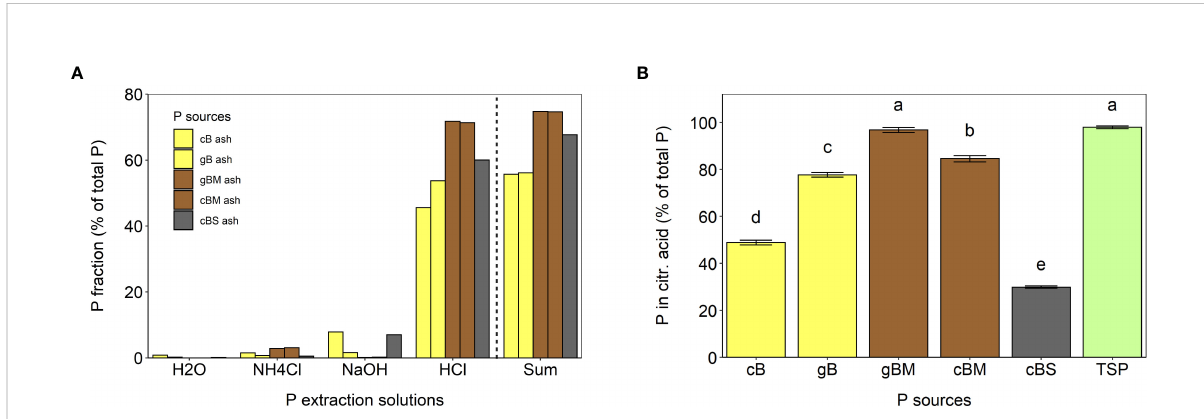
FIGURE 1 Phosphorus extractability from cB, gB, gBM, cBM and cBS ashes in various solutions. (A) Sequential P extractability in water, 1 M NH 4 Cl at pH 7, 0.1 M NaOH and in 0.5 M HCl. (B) Phosphorus extractability with 2% citric acid. The error bars represent standard errors of the means. Different letters indicate statistical differences between P extractabilities (Tukey ’ s HSD test, p ≤ 0.05, n =